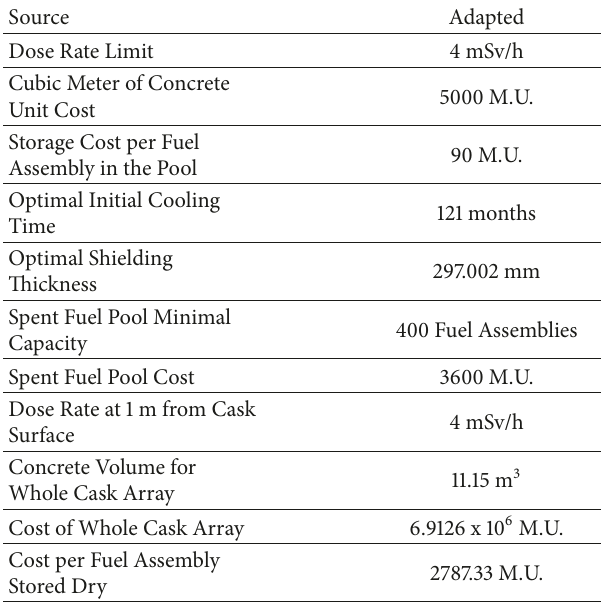
Table 7: Optimal result data for a given set of example parameters with 4 mSv/h as the dose rate limit.